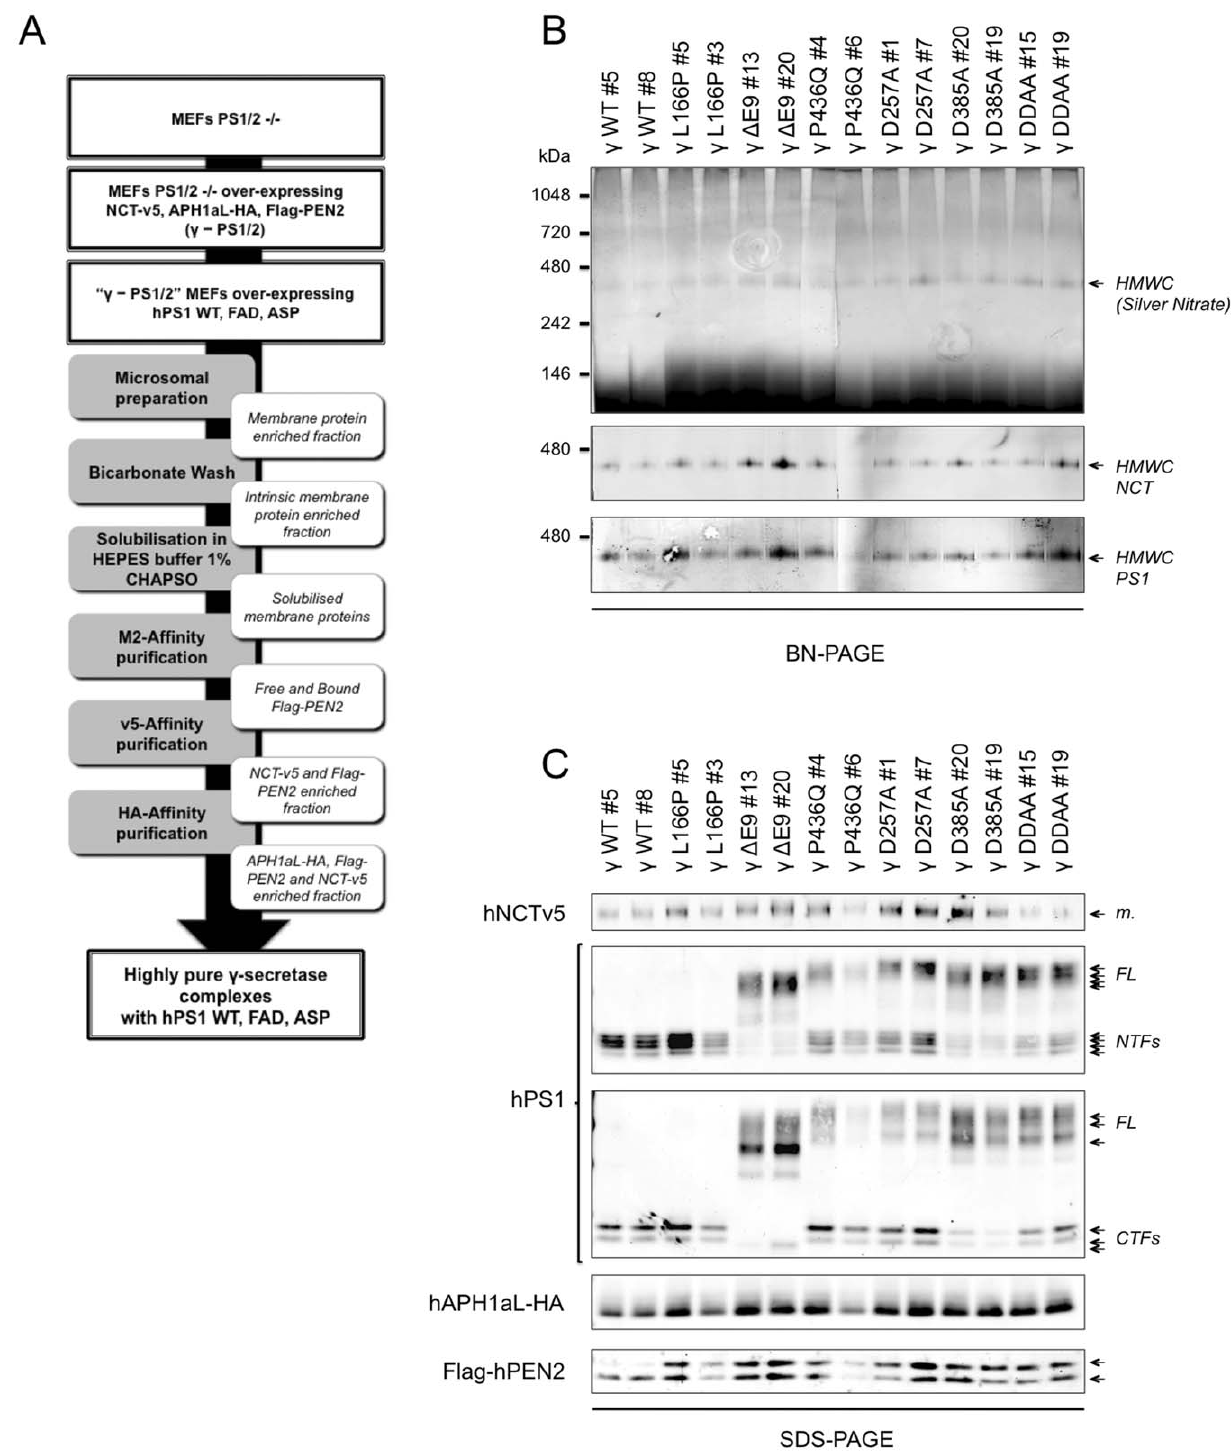
Figure 4. High-grade purification of human c -secretase complexes with FAD-linked PS1 mutants. (A) Schematic representation of the c - secretase purification process. Briefly, Presenilin double-knockout MEFs were used to first generate cell lines that stably overexpress human c -secretase complexes containing different PS1 variants. Next, these cell lines were used for a multi-step purification procedure as described in the material and methods. (B) Blue-Native PAGE analysis of purified c -secretasecomplexes made of different PS1 variants. Equal volumes of the different purified c -secretase preparations were separated by native-PAGE on a 4–16%Bis-Tris gel, andstained with silver nitrate (top panel),orimmunostained for NCT (NCT164,middle panel) or PS1-NTF (ab10281, bottom panel) as indicated. c -Secretase complexes appeared on the gel as high molecular weight complexes (HMWCs) of , 350 kDa. Note thatthelevels of HMWCswere similarfor all clones. (C)Equal volumes ofpurified c -secretase complexes withFAD-linkedPS1mutants were separated under denaturing conditions (SDS-PAGE) and immunostained with anti-NCT (NCT164), anti-PS1-NTF (MAB1563), anti-PS1-CTF (MAB5232), anti- HA(3F10),oranti-Flag(M2)antibodies.Twoindependentpurifications wereperformedoneachclonewithsimilarresults. Arepresentativedatasetis shown.